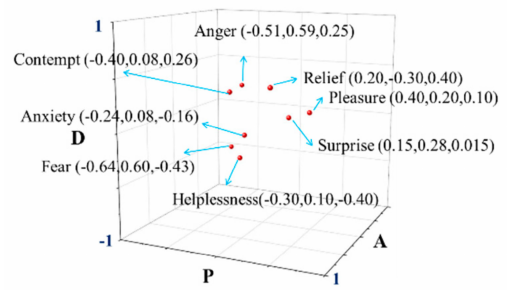
Figure 10. Distribution of the eight emotions in PAD space.